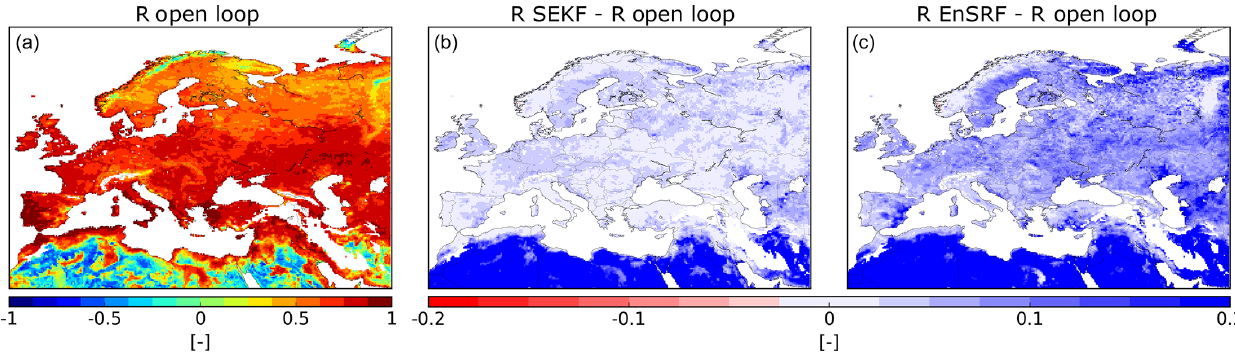
Figure 8. (a) Correlation ( R ) between observed (rescaled) SSM and its open-loop equivalent for the period 2008–2017 and R difference between assimilation experiments (SEKF in b and EnSRF in c ) and the open